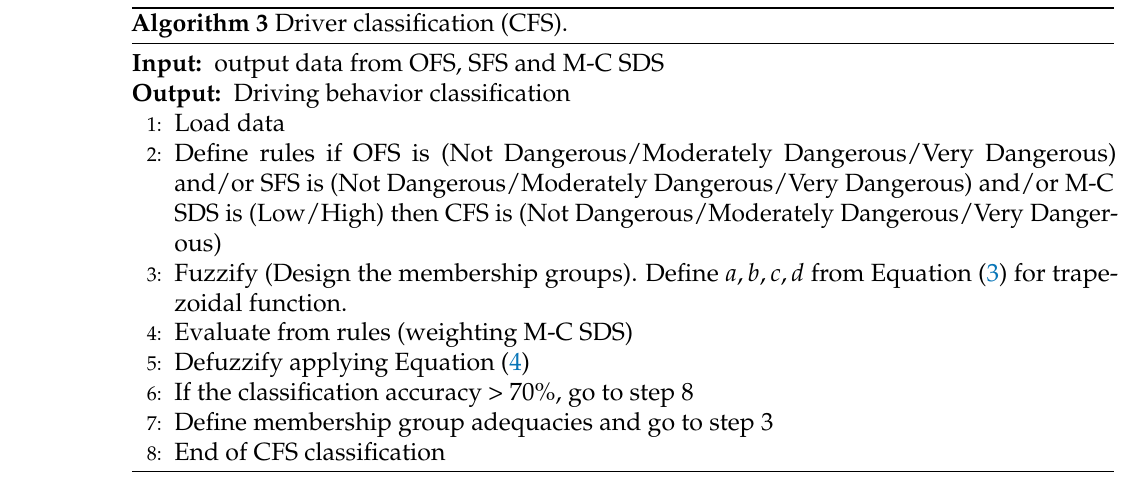
Algorithm 3 Driver classification